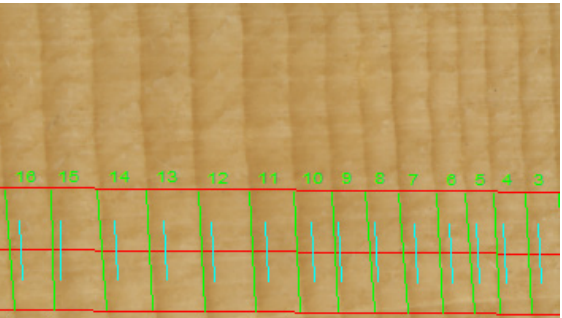
Figure 2. The demarcation boundary between early wood and late wood performed with the WinDENDRO density image analysis system.